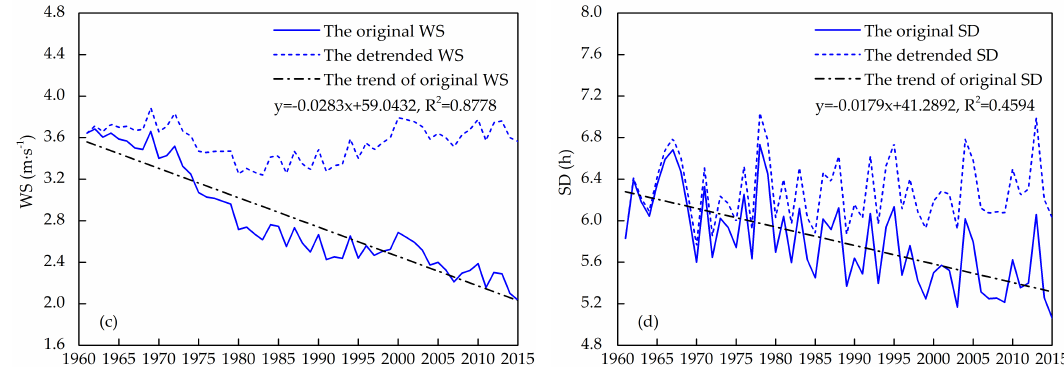
Figure 4. The original and detrended climatic factors ( a ) TA, ( b ) VP, ( c ) WS, and ( d ) SD for the whole of Jiangsu province during 1961 − 2015.